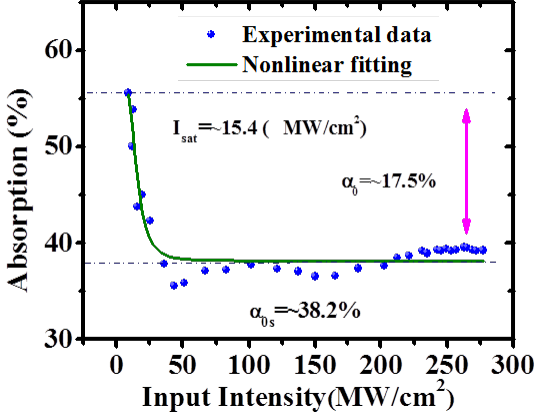
Figure 3. Measured nonlinear absorbance of the TI-PCF SA